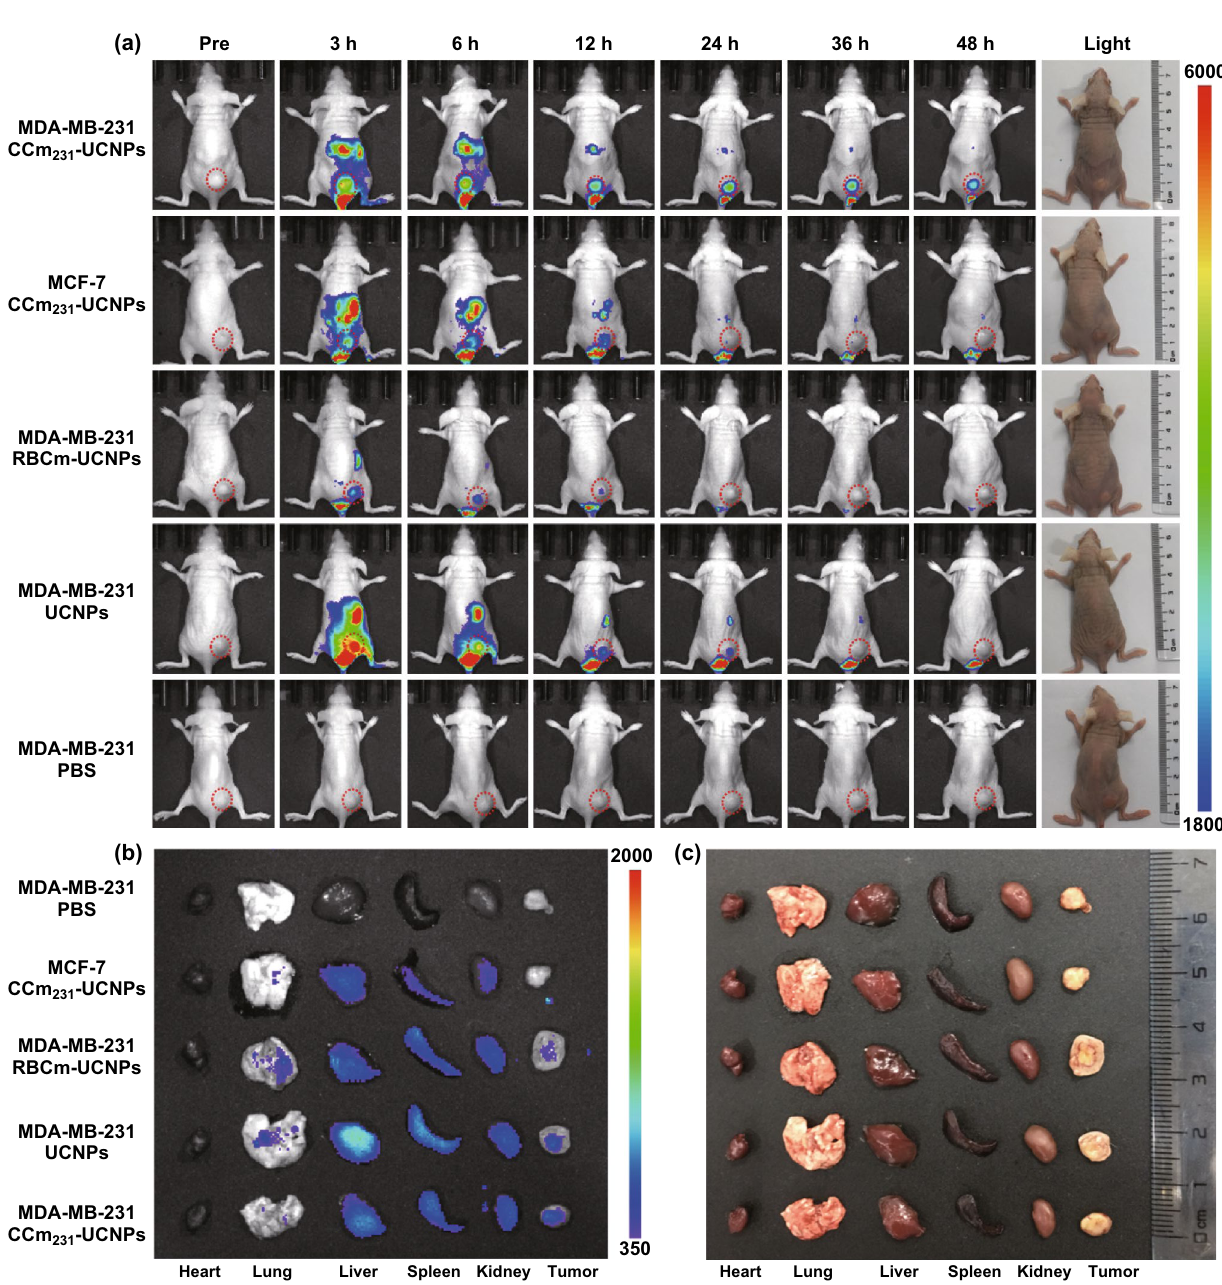
Fig. 2 Homologous‑targeting evaluation and in vivo upconversion luminescence (UCL) imaging. a BALB/c nude tumor‑bearing mice injected with PBS or PBS containing UCNPs, RBCm‑UCNPs, and CCm 231 ‑UCNPs at different times after the injection. b , c Ex vivo UCL images of tumors and major organs of the killed mice at 48 h after the